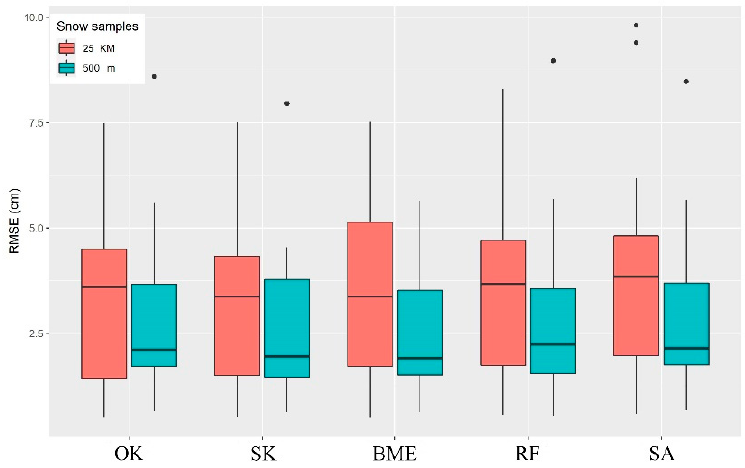
Figure 2. Boxplot of RMSE for two types of snow plots in